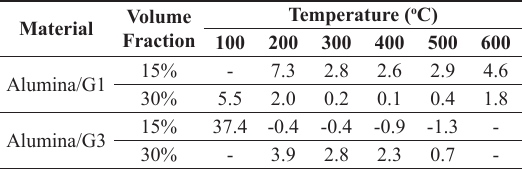
Table 4. Percentual difference between the predicted Young modulus with respect to the experimental values obtained by Tessier-Doyen 7